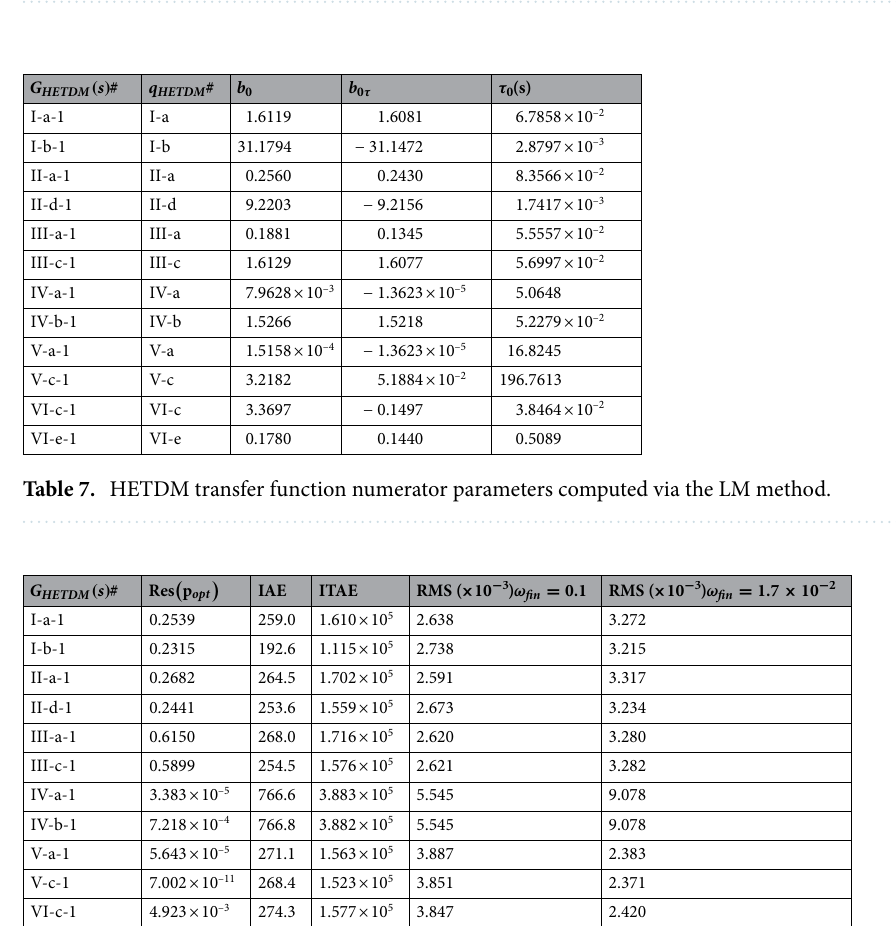
control parameters are set as in “Initial denominator parameters estimation”. Table 7 displays the most distinguished results such that two parameters ‘ sets from each of the six pole spec- trum families are selected. The corresponding Res , IAE and ITAE criteria values from unit step responses, and RMS values from Nyquist plots for ω fin = 0.1 and ω fin = 1.7 × 10 − 2 are provided in Table 8. Compared to SFOTDMs (Tables 2, 3), IAE and ITAE criteria values of unit step responses for HETDMs have been enhanced in all six families of models. Contrariwise, frequency-domain error measures have not been improved; the results in Table 8 are very close to those displayed in Table 3. The unit step responses and Nyquist plots of some selected HETDMs are displayed in Figs. 12 and 13, respectively. The models are selected such they dynamic responses differ significantly. Regarding non-displayed responses, they are very close to some displayed ones. Namely, in the time domain, II-a-1 almost meets III-a- 1, yet the latter is faster. II-d-1 and III-c-1 are close to I-a-1. IV-a-1 and IV-b-1 almost coincide, yet IV-b-1 is faster. The same assertion holds for the pair V-c-1 and V-a-1. Finally, VI-e-1 is nearly identical to V-a-1. In the frequency domain, II-a-1 is close to the pair I-a-1 and III-a-1 at the whole frequency range. II-d-1 approaches I-a-1 at low frequencies and I-b-1 at higher ones. III-c-1 is almost identical to III-a-1 for all frequencies. Finally, pairs V-a-1/V-c-1 and VI-c-1/VI-e-1 have frequency responses very close to each other.